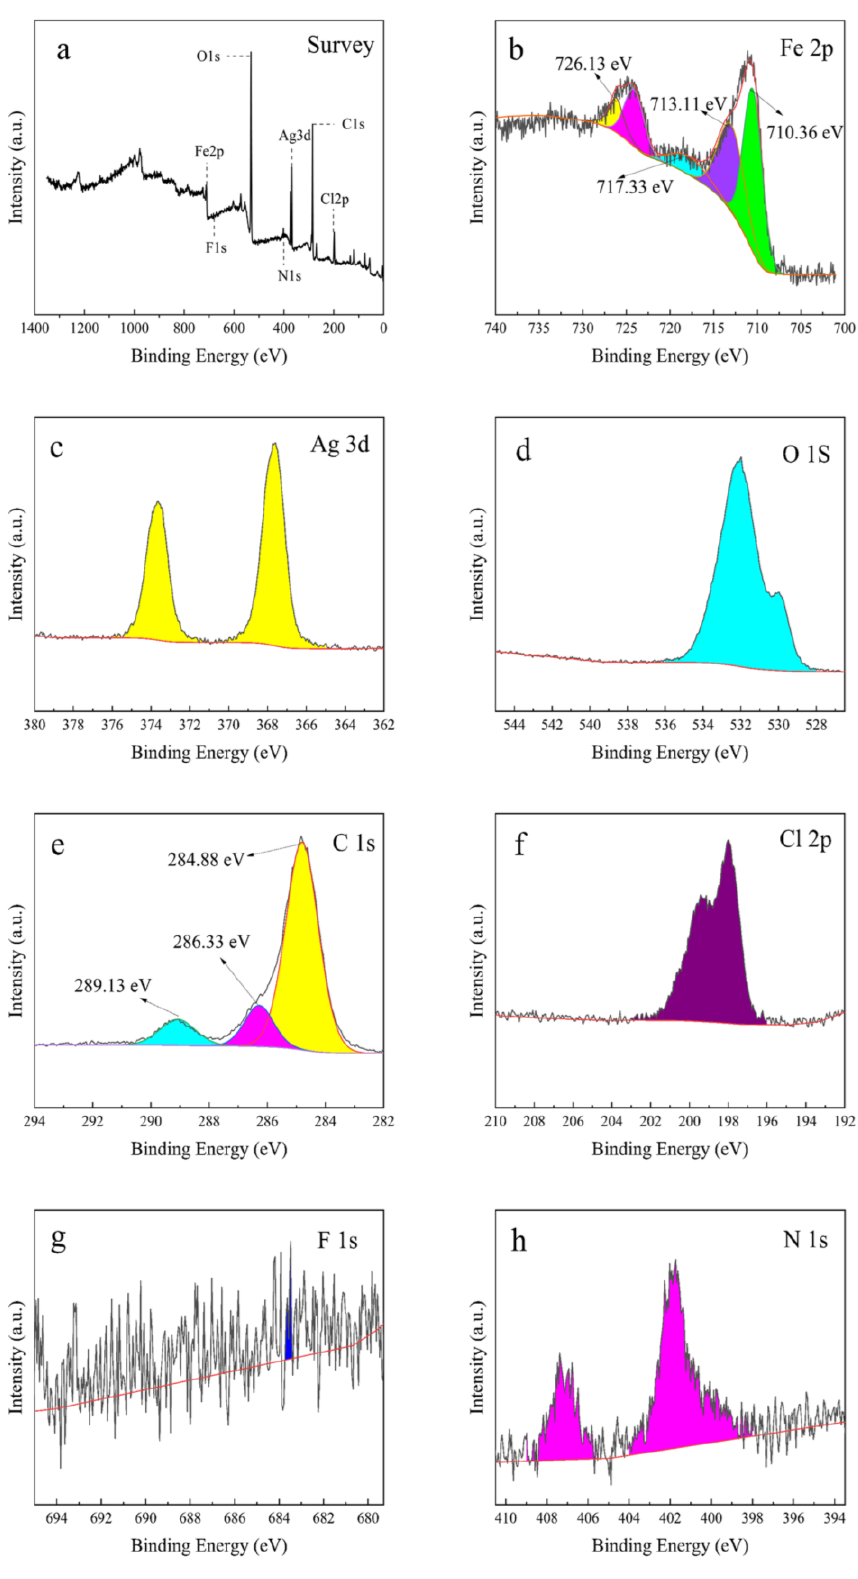
Figure 8. Elemental XPS spectra of MIL-101(Fe)@Ag (Ag 0.0127 wt%). ( a ) Full XPS spectrum of MIL-101(Fe)@Ag (Ag 0.0127 wt%). ( b ) XPS spectrum of Fe. ( c ) XPS spectrum of Ag. ( d ) XPS spectrum of O. ( e ) XPS spectrum of C. ( f ) XPS spectrum of Cl. ( g ) XPS spectrum of F. ( h ) XPS spectrum of N.